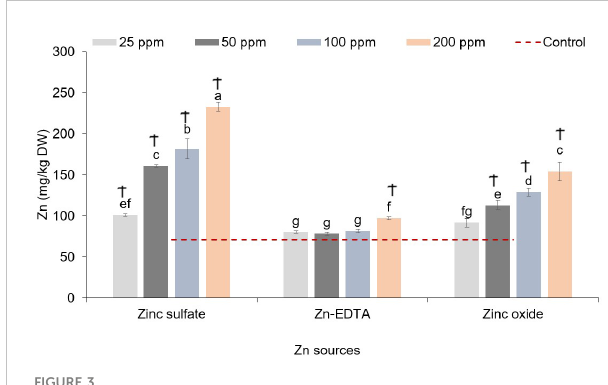
FIGURE 3 Zinc source and application rate interaction effect Zn content in sun fl ower microgreens (mg/kg DW). Vertical bars indicate average values and the standard error ( n = 3). Different letters indicate signi fi cant differences at p = 0.05 by the Fisher LSD test. The dashed line indicates the average value of the untreated control. Ϯ indicates a signi fi cant difference compared to the control. Ϯ indicates a signi fi cant difference compared to the control using contrast in the linear mixed